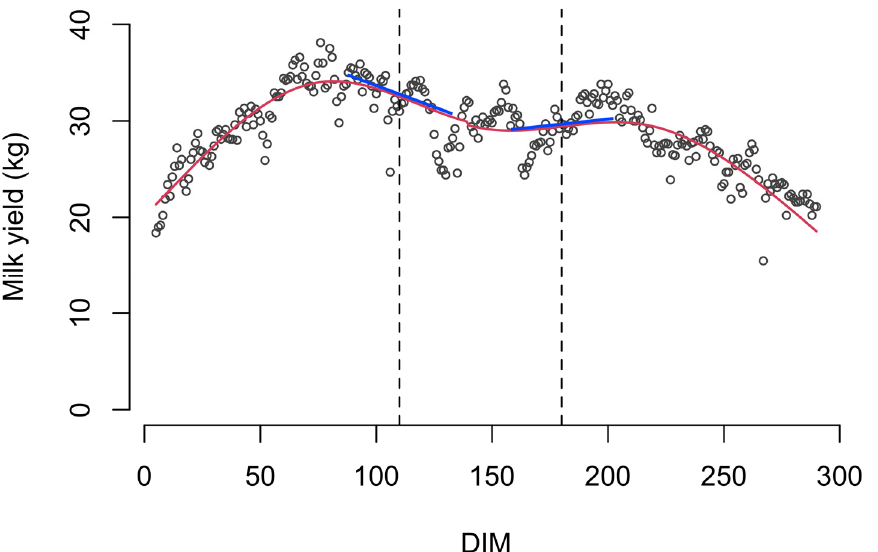
Figure 1. Tangent (blue) lines to the estimated milk yield trajectory (red curve) at time points 𝑡 = 110 DIM and 𝑡 = 180 DIM for one cow (5 ≤ DIM ≤ 290) of one farm randomly chosen. The joint model examines the association between the slope of the tangent line at 𝑡 and the risk of being culled at 𝑡 .